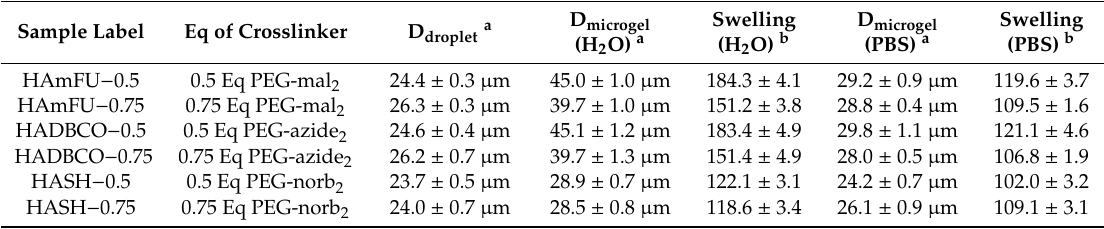
Table 4. Emulsion droplet and corresponding microgel diameters depending on variations of crosslinker concentrations and the choice of click